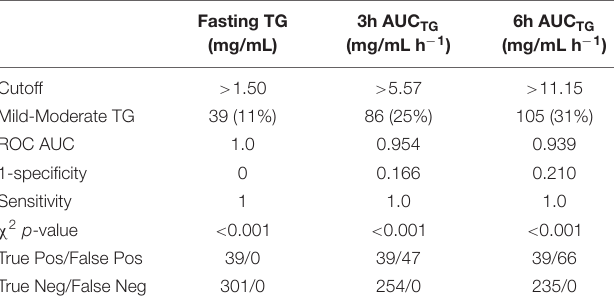
TABLE 3 | Postprandial and fasting mild-to-moderate hypertriglyceridemia status agreement in the phenotyping study ( n = 340). Fasting TG (mg/mL) Cutoff > 1.50